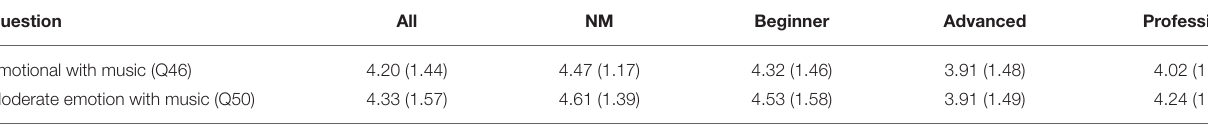
TABLE 16 | Mean and SD of responses to musical-emotion related questions, grouped by musicianship. Question